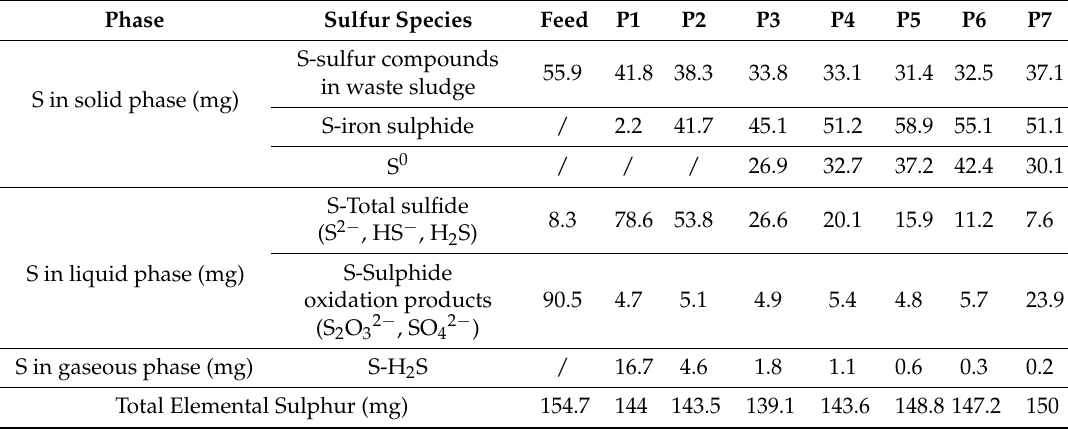
Table 4. The mass distribution of sulfur compounds (mg) in the system before and after semi- continuous anaerobic and microaerobic digestion of activated sludge supplemented with RSI over seven periods of operation associated with stepwise increases in oxygen